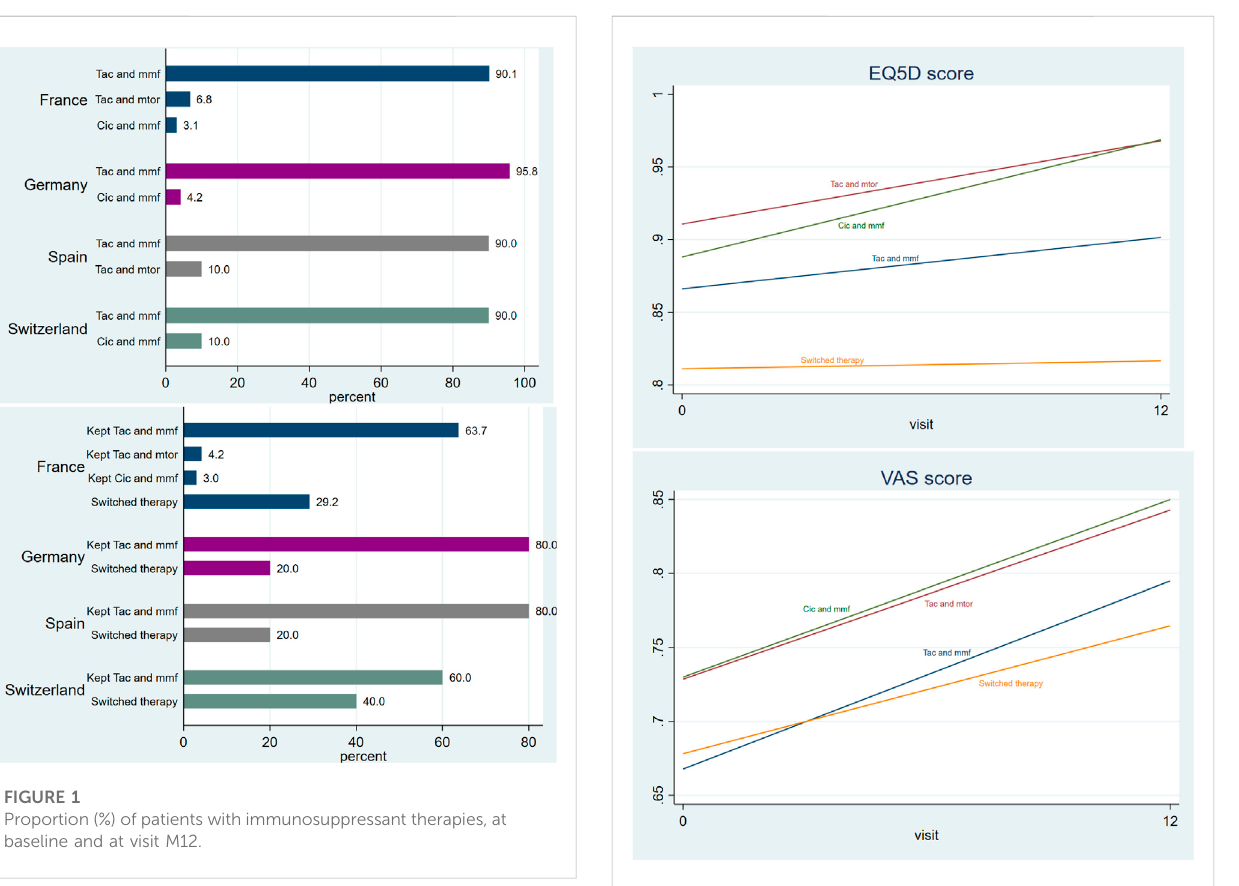
FIGURE 2 Mean EQ-5D scores and VAS scores by therapy type at baseline and in the last visit (trend) among only those people with non-missing EQ-5D and VAS scores ( N = 205). *Overall mean EQ-5D score changed from 0.85 to 0.88, and mean VAS changed from 0.67 to